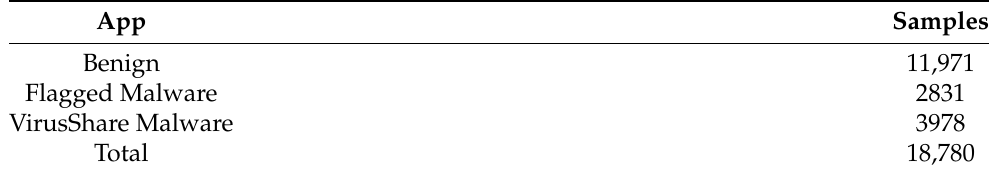
Table 1. Dataset description.